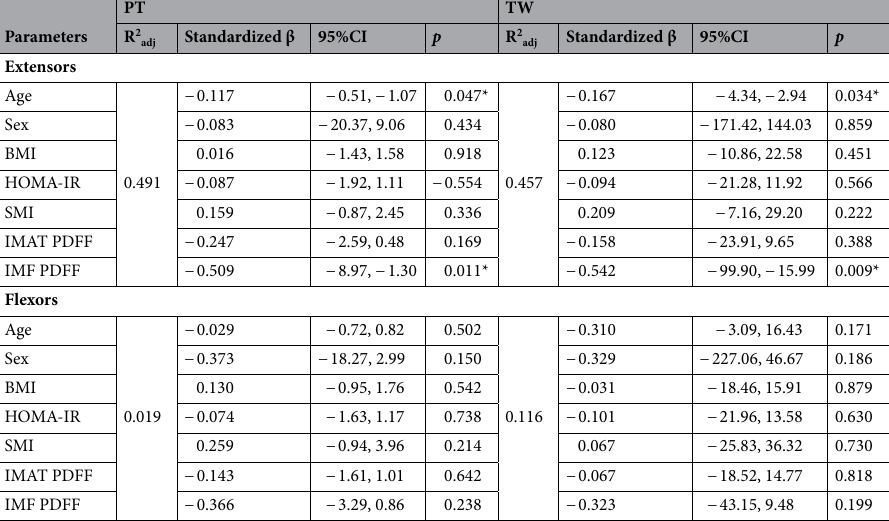
Table 4. Multiple linear regression analysis of PT and TW of thigh muscles in T2DM patients. BMI body mass index, SMI skeletal muscle index, HOMA-IR homeostasis model assessment-insulin resistance, PDFF proton density fat fraction, PT peak torque, TW total work. * p <